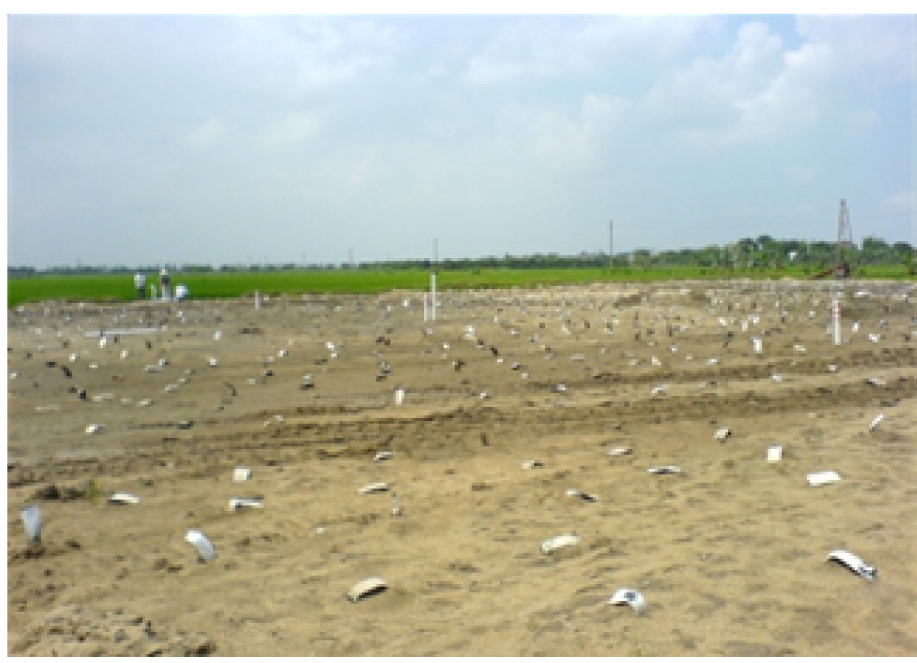
Figure 5. On-site layout image of the PVDs. After the PVDs were laid, on-site monitoring instruments were installed (Figure 6). Field settlement monitoring relied on layered settlement pipes and inclinometer